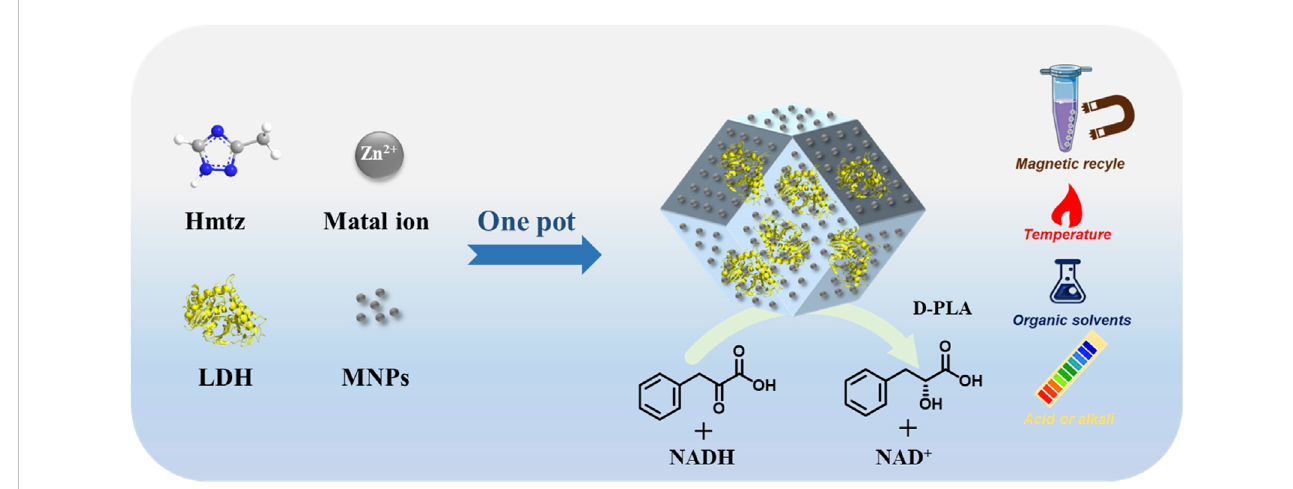
FIGURE 1 The synthesis of the biocatalyst LDH/MNPs@MAF-7 and the catalytic activity evaluation.